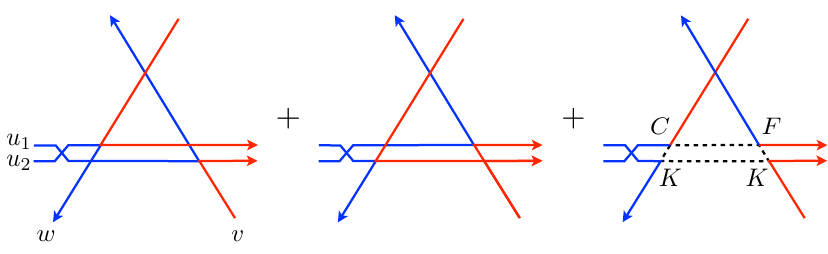
Figure 7 . Processes contributing to the matrix part for the hexagon splitting of a two-magnon wave function, with the magnons arranged as in left panel of (cid:12)gure 4. One of them displays a fermion loop represented by the dashed line. (The grading factors drop out since the number of fermions involved is